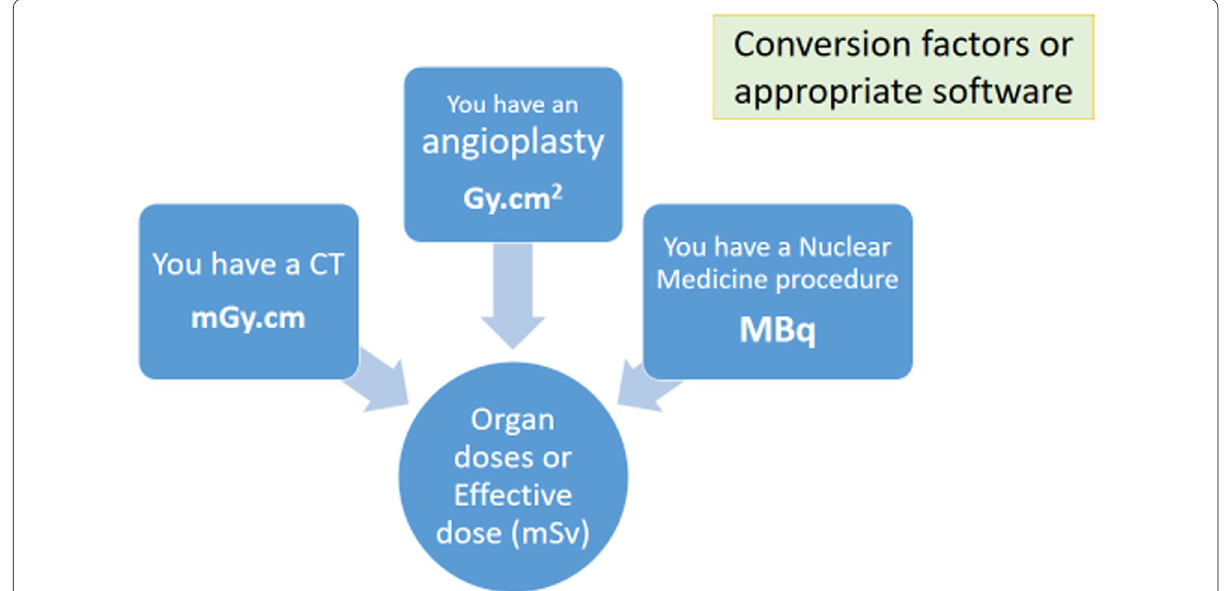
Fig. 1 Estimation of effective doses from different imaging modalities using the conversion